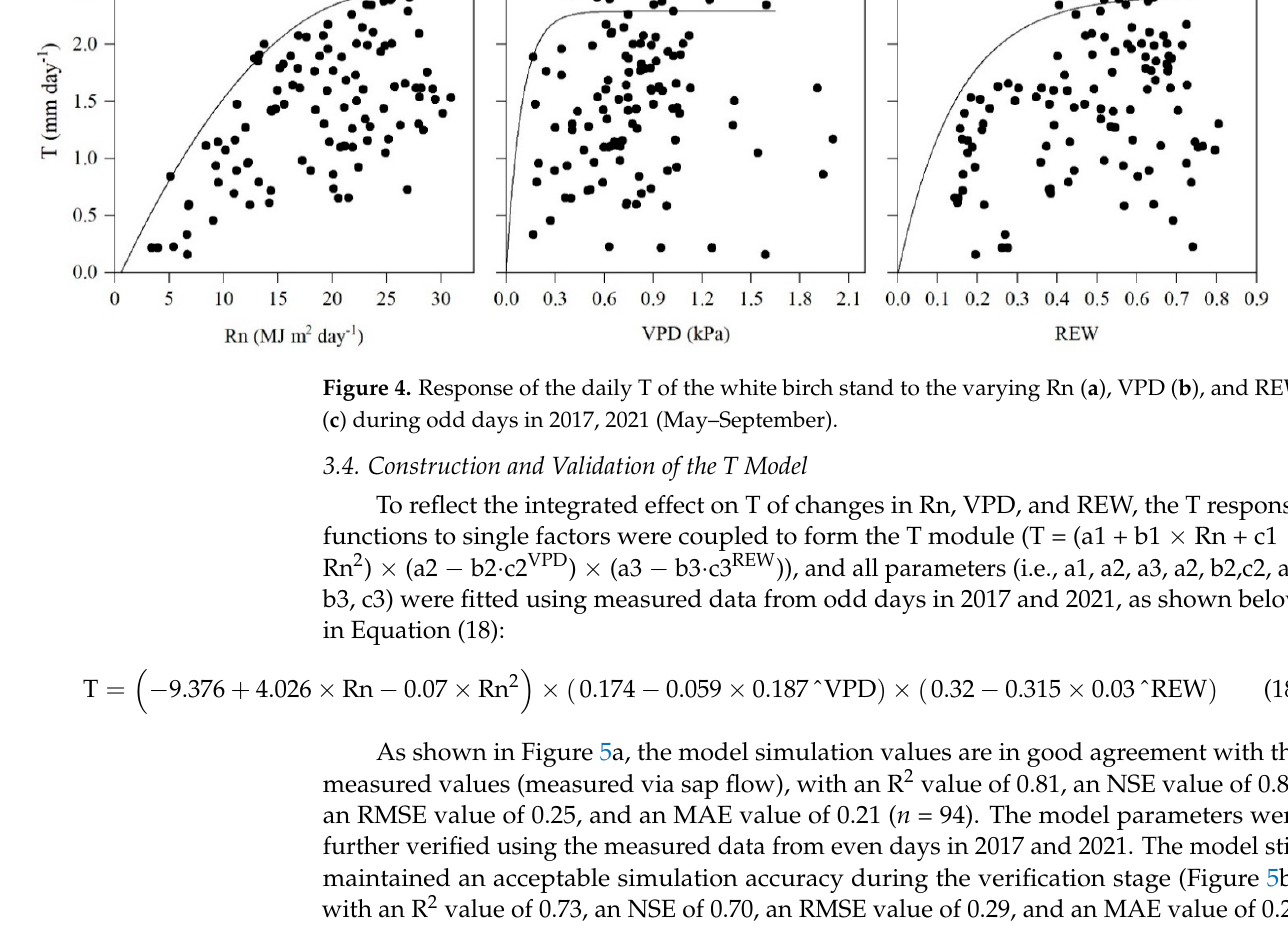
Figure 5. Comparison of the observed and simulated T during the calibration (odd days in 2017 and 2021, ( a )) and validation (even days in 2017 and 2021, ( b )) phases.